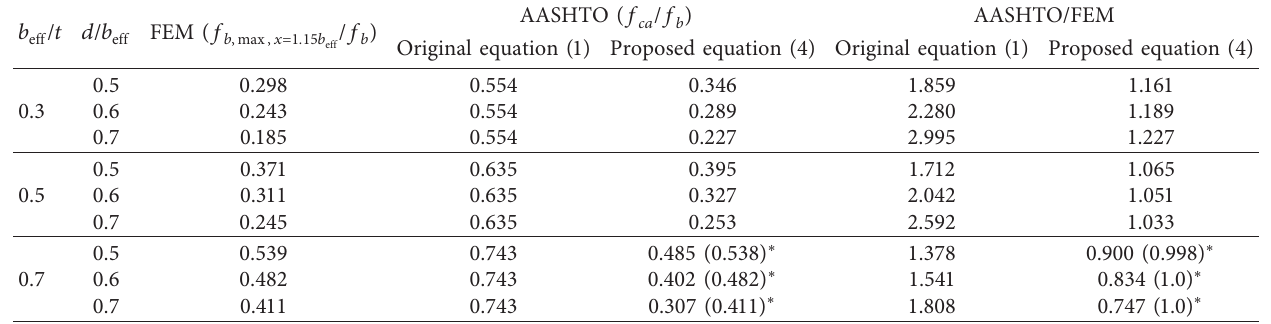
Table 2: Comparison of longitudinal stress (with a duct hole, x � 1 . 15 b